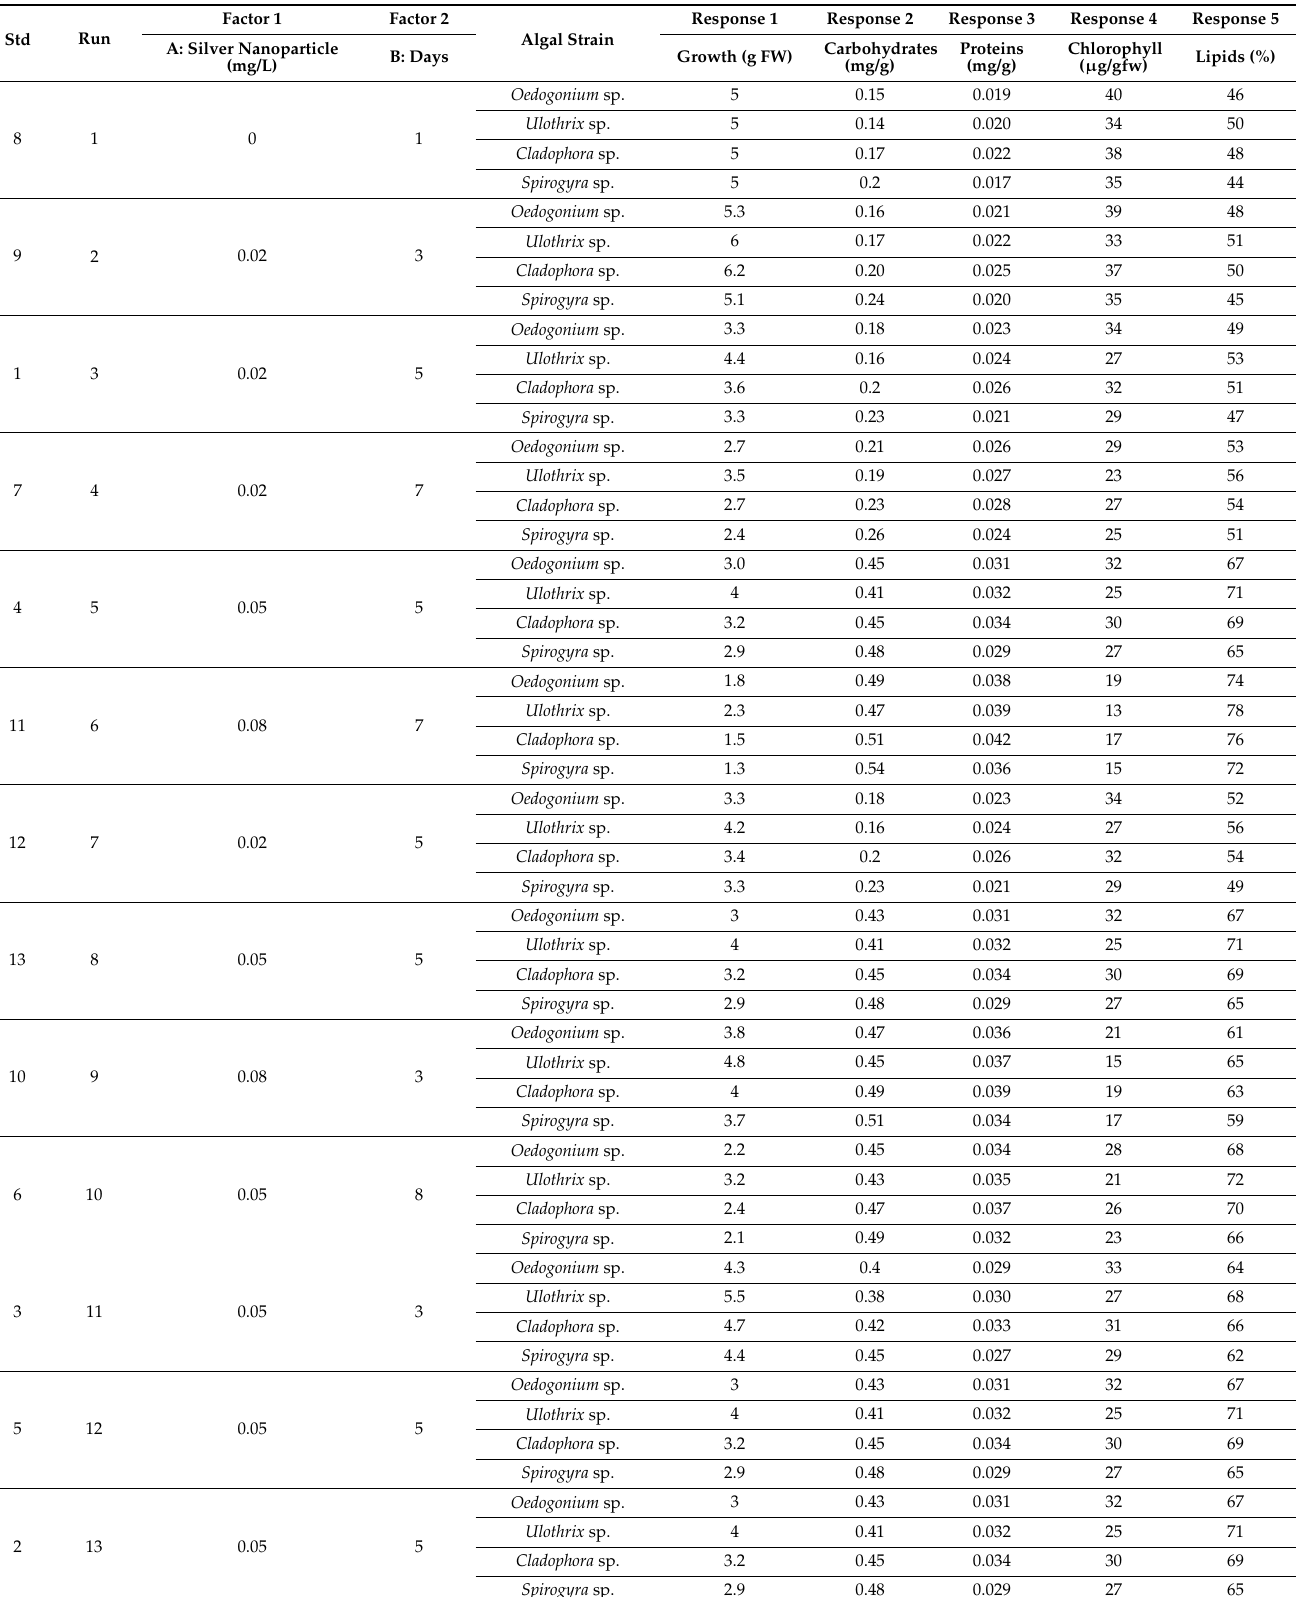
Table 2. The central composite design of combined effect of silver nanoparticles, metabolites and stress duration (Days) in algal